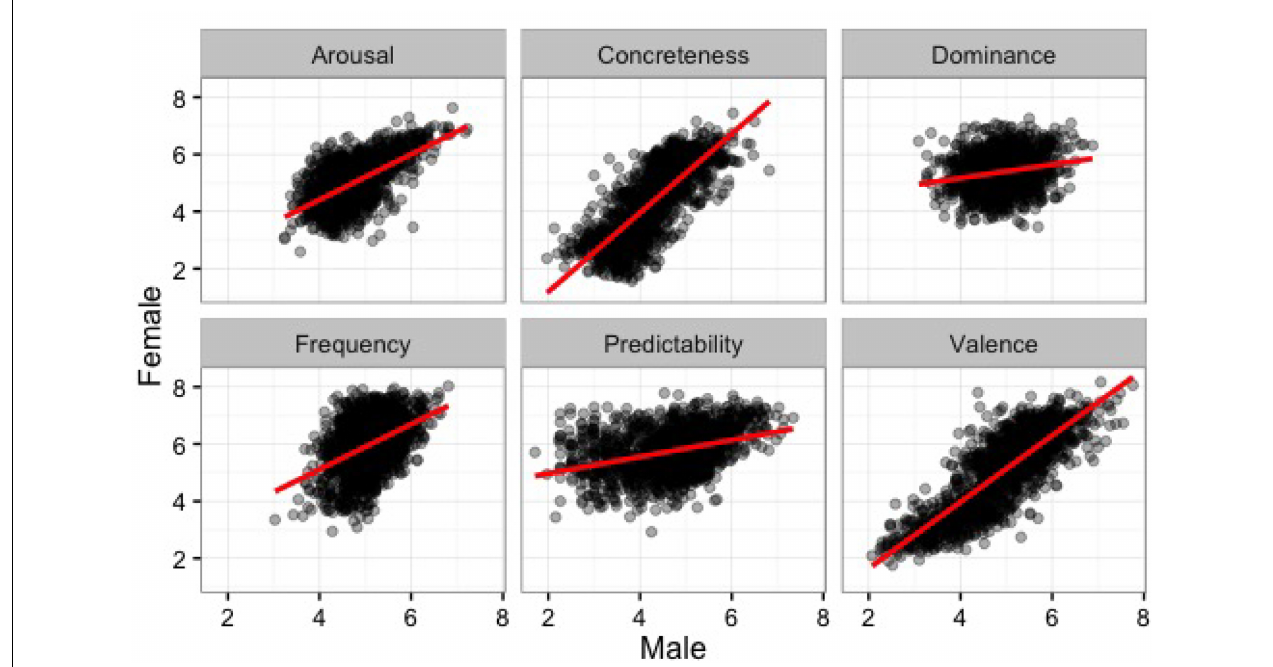
FIGURE 7 | Male ratings for each dimension plotted against female